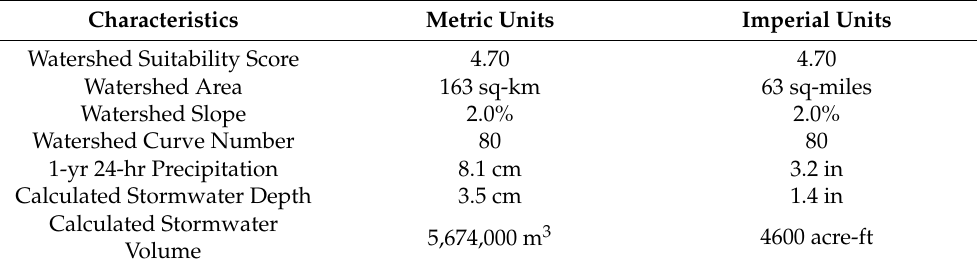
Figure 9. Identified watershed and potential reservoir location. Location highlighted in red. Adapted from WWF’s [37] HydroSHEDs database. Table 4. Watershed characteristics.